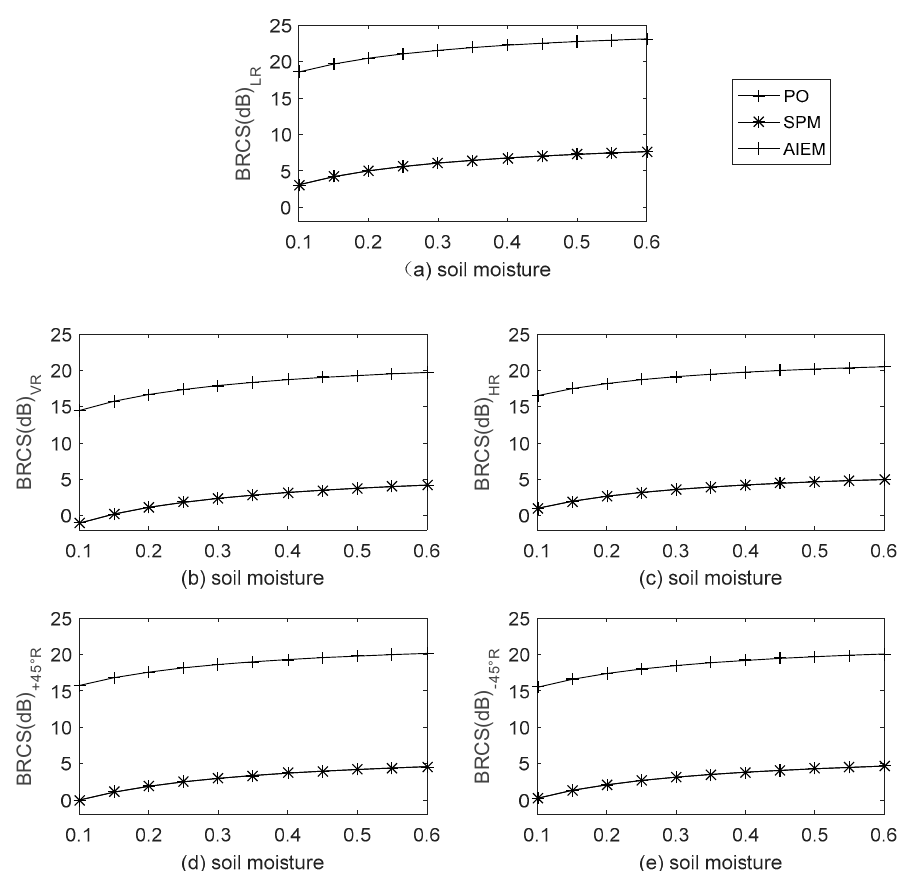
Figure 4. Soil moisture e ff ects on BRCS at five di ff erent polarizations. θ i = 30, θ s = 30, ϕ s = 0. Subfigures a to e represent the polarizations of LR, VR, HR, + 45 ◦ R and − 45 ◦ R,